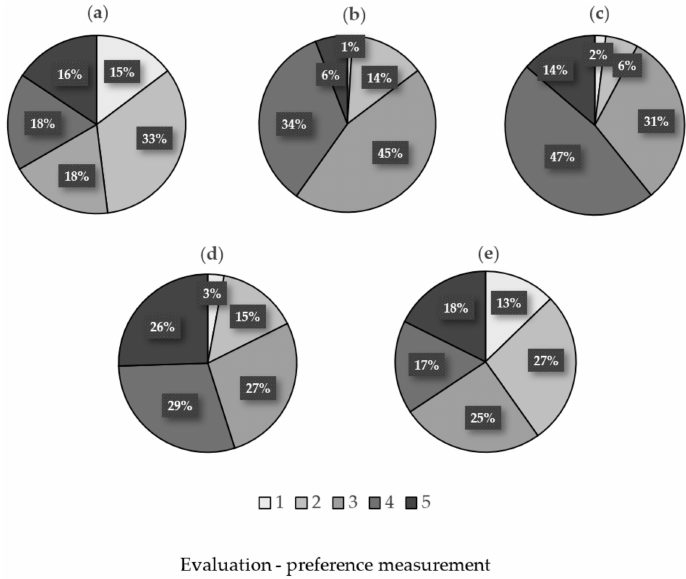
Figure 18. The percentage distribution of the preferences for the individual shades of the samples—birch veneer. ( a ) Veneer—untreated; ( b ) veneer—treated at 170 ◦ C / 3 h; ( c ) veneer—treated at 190 ◦ C / 3 h; ( d ) veneer—treated at 190 ◦ C / 5 h; ( e ) veneer—treated at 200 ◦ C / 3